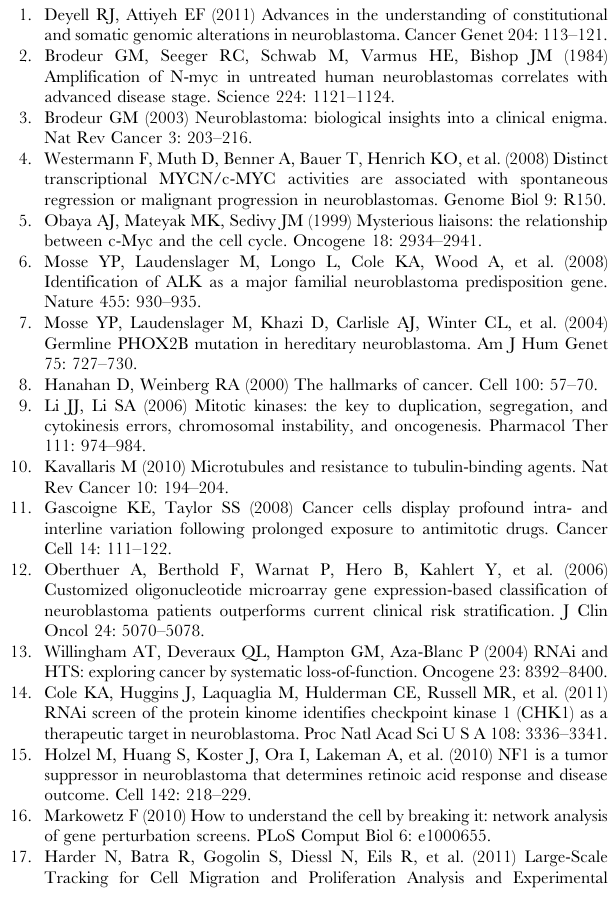
also available as well as the calculated phenotpye scoring and related quality measures. Figure S6 Cell arrays before and after normalization. The color key shows the distribution of the cell counts over the array. Left: A cell array before normalization, showing the edge effects with high cell counts in the most upper row. Right: The same cell array after B-score normalization. It shows a smoothing of the edge effects. Blue boxes represent empty spots which were not a part of the screen. Table S1 240 genes selected for knockdown screen. Table S2 Pathways of Reactome and gene groups from Gene Ontology which were enriched in the screened genes. Table S3 Confusion matrix for SH-EP cell line. Table S4 Confusion matrix for SK-N-BE(2)-C cell line.